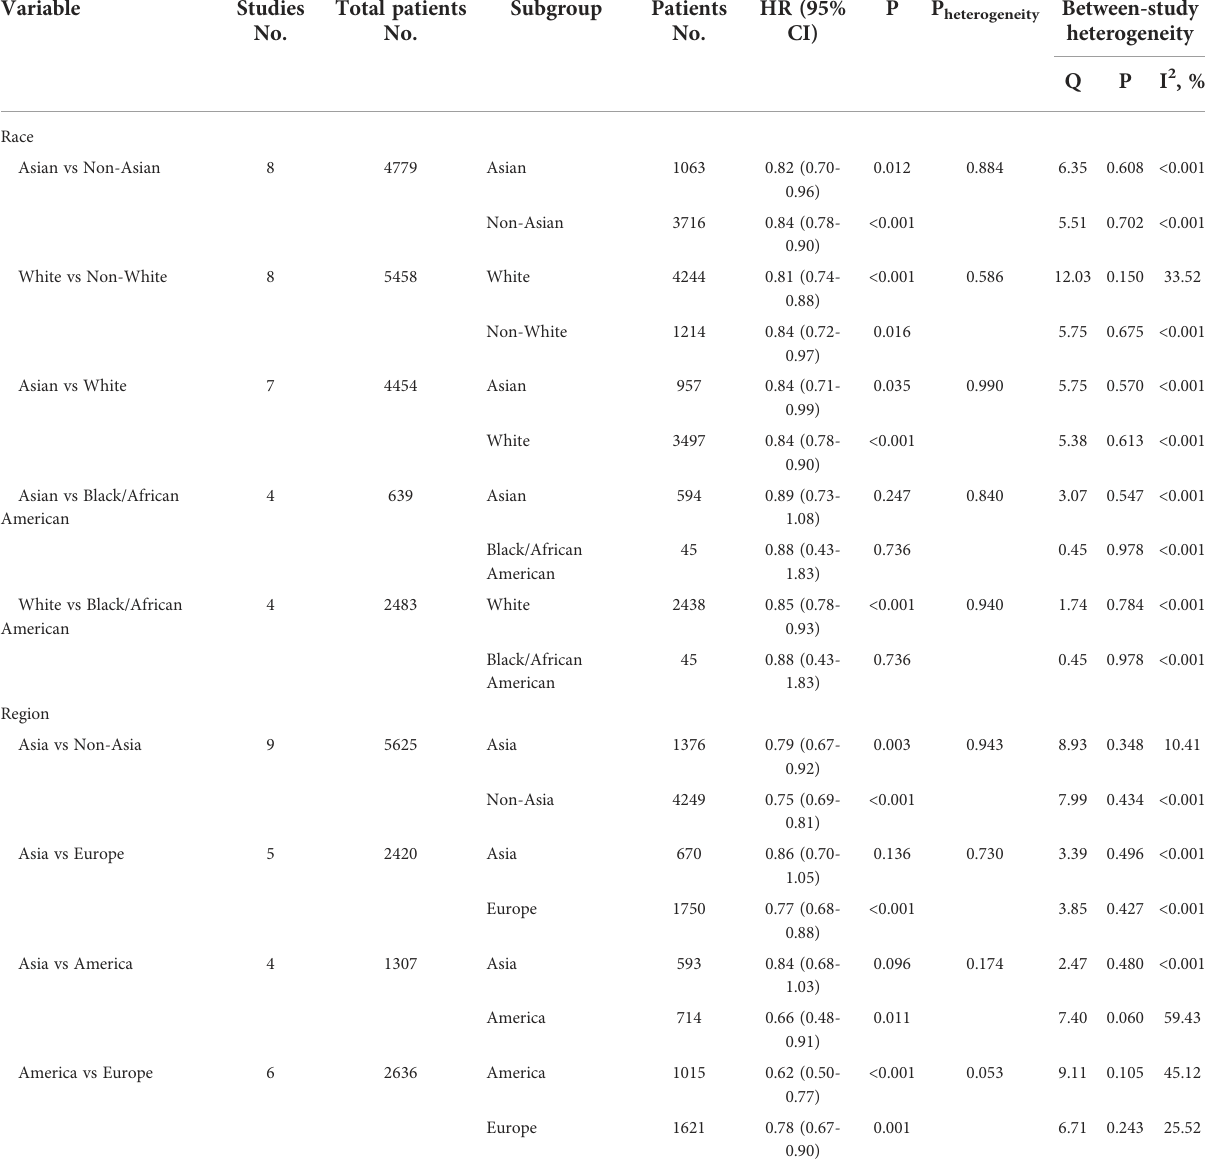
TABLE 4 Differences in ef fi cacy of IO vs control therapies by race and region. Variable Studies